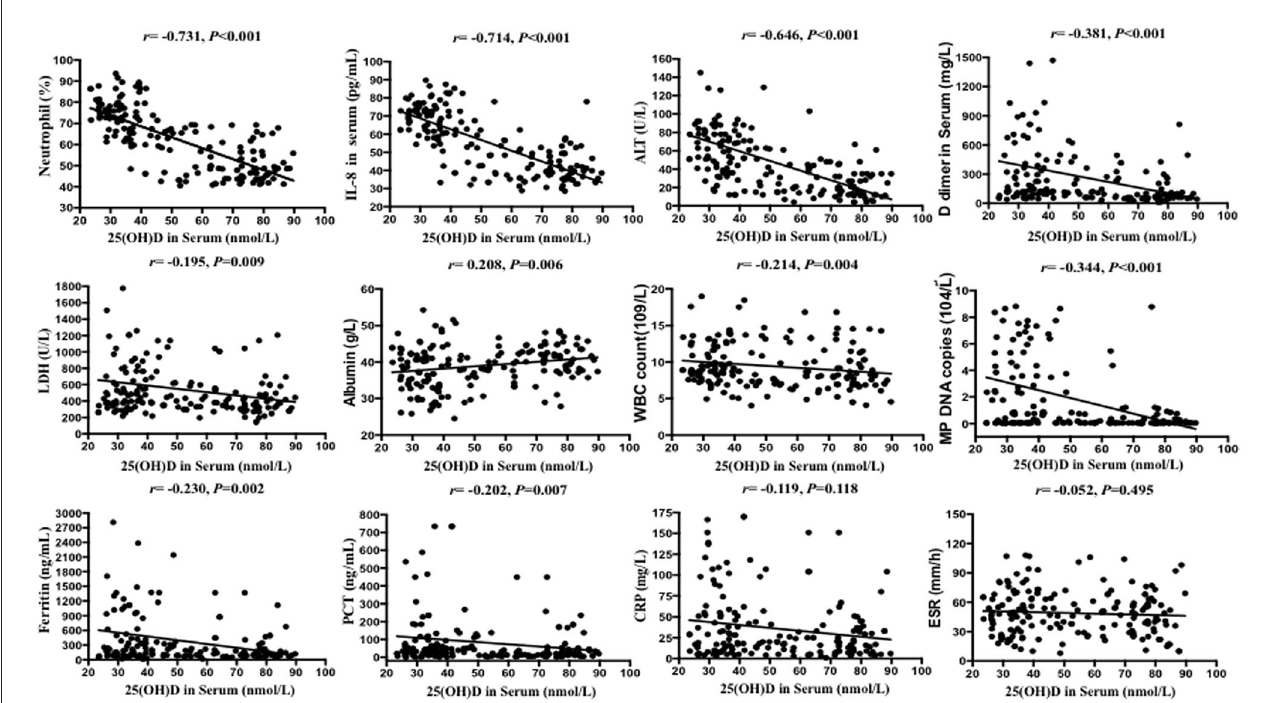
FIGURE2 Scatter plots of Spearman’s and Pearson’s correlational analyses. Correlational analyses between 25(OH)D and neutrophils (%), IL-8, ALT, DD dimer, LDH, albumin, WBC count, MP DNA copies, ferritin, PCT, CRP, and ESR were performed. Each symbol represents the measurement of one case. The continuous line shows the least-square linear